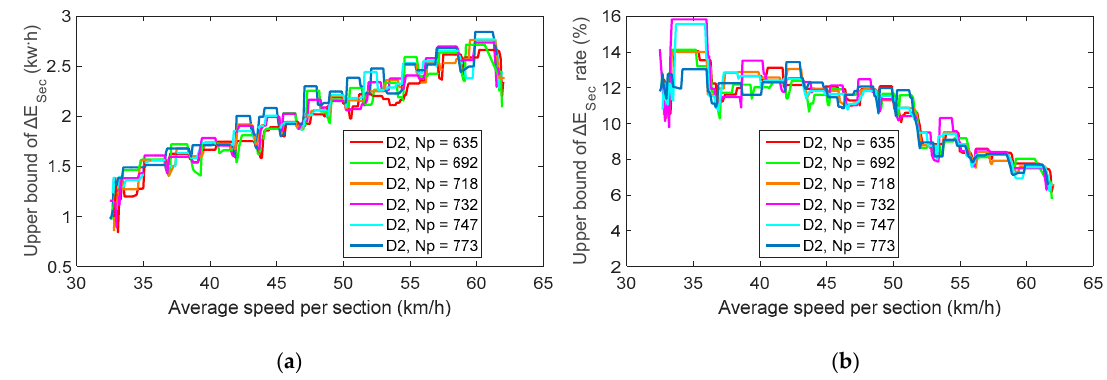
Figure 18. Comparison of upper boundaries with different N p values (weekday, SH-TQ). ( a ) ASS- REN-PLF boundaries; ( b ) ASS-RER-PLF boundaries.